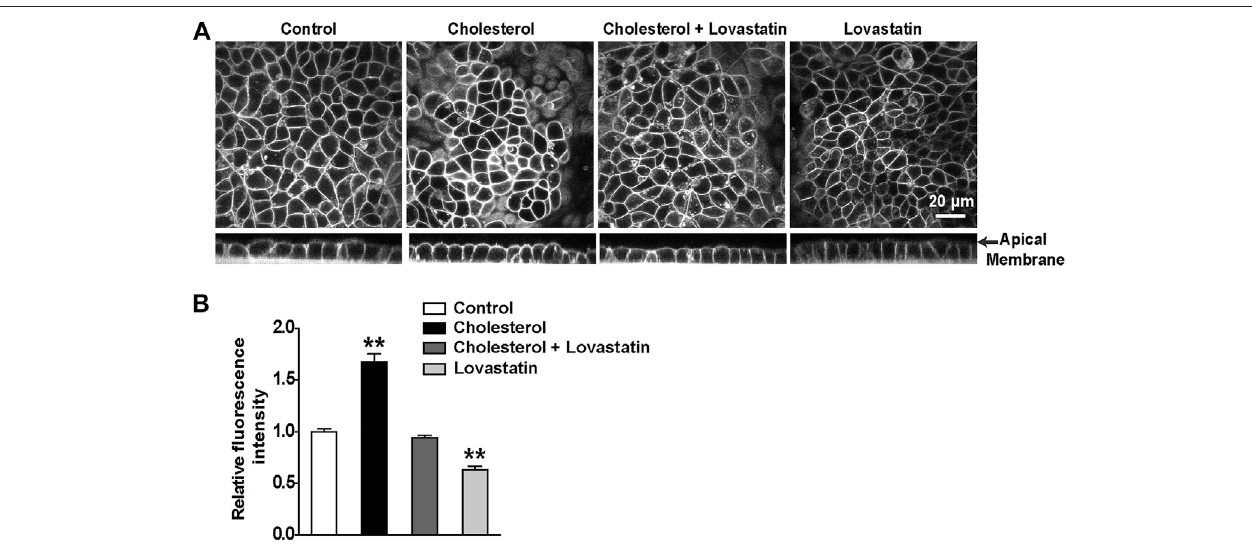
FIGURE 1 | Treatment of cells with cholesterol increases, but with lovastatin decreases, membrane cholesterol levels in mpkCCD c14 Cells. (A) Representative confocal microscopy images of mpkCCD c14 cells stained with fi lipin either from XY optical sections near the apical membrane ( top ) or from XZ optical sections ( bottom ). (B) Summary plots of fl uorescence intensity of cholesterol levels under each indicated conditions. Cells were either under control conditions or treated for 48 hrs with 30 μ g/ml cholesterol alone, 30 μ g/ml cholesterol plus 5 μ M lovastatin, or 5 μ M lovastatin alone, respectively. Data are from 18 images in three sets of separate experiments. ** P < 0.01, signi fi cantly different with